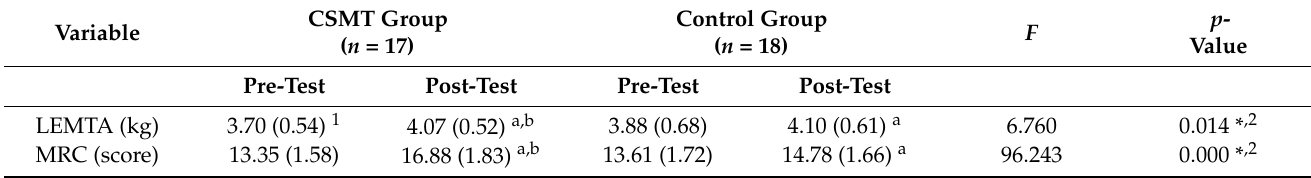
Table 3. Comparison of LEMTA and MRC between CSMT and Control groups ( N =